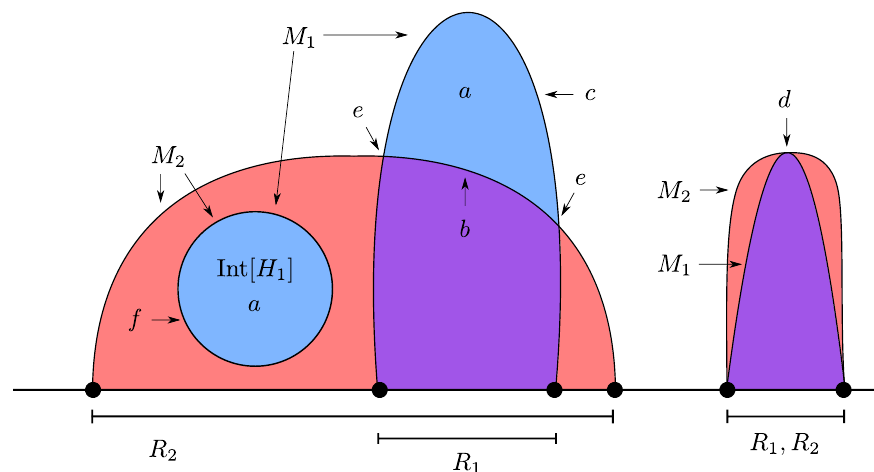
Figure 7 . A generic setup that violates entanglement wedge nesting. Two boundary regions are depicted, R 2 and R 1 (cid:26) D [ R 2 ], with their respective quantum maximin surfaces M 2 and M 1 . All types of points that would violate nesting are labelled with a letter. Points of type a are codimension one subregions, while all other points are subregions of the maximin surfaces. Regions shaded light blue correspond to Int[ H 1 ] while regions shaded red correspond to Int[ H 2 ]. Regions which are contained by both homology hypersurface, Int[ H 1 ] \ Int[ H 2 ], are shaded